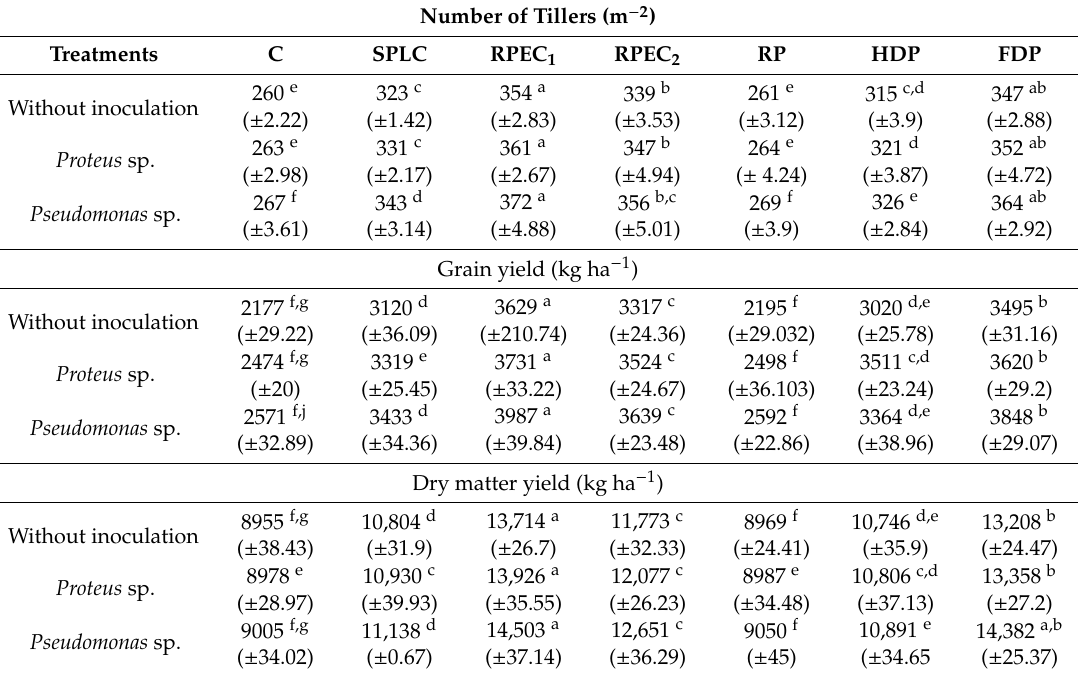
Table 4. E ff ects of plant growth promoting rhizobacteria (PGPR), P-enriched compost and inorganic fertilizers on yield and yield components on